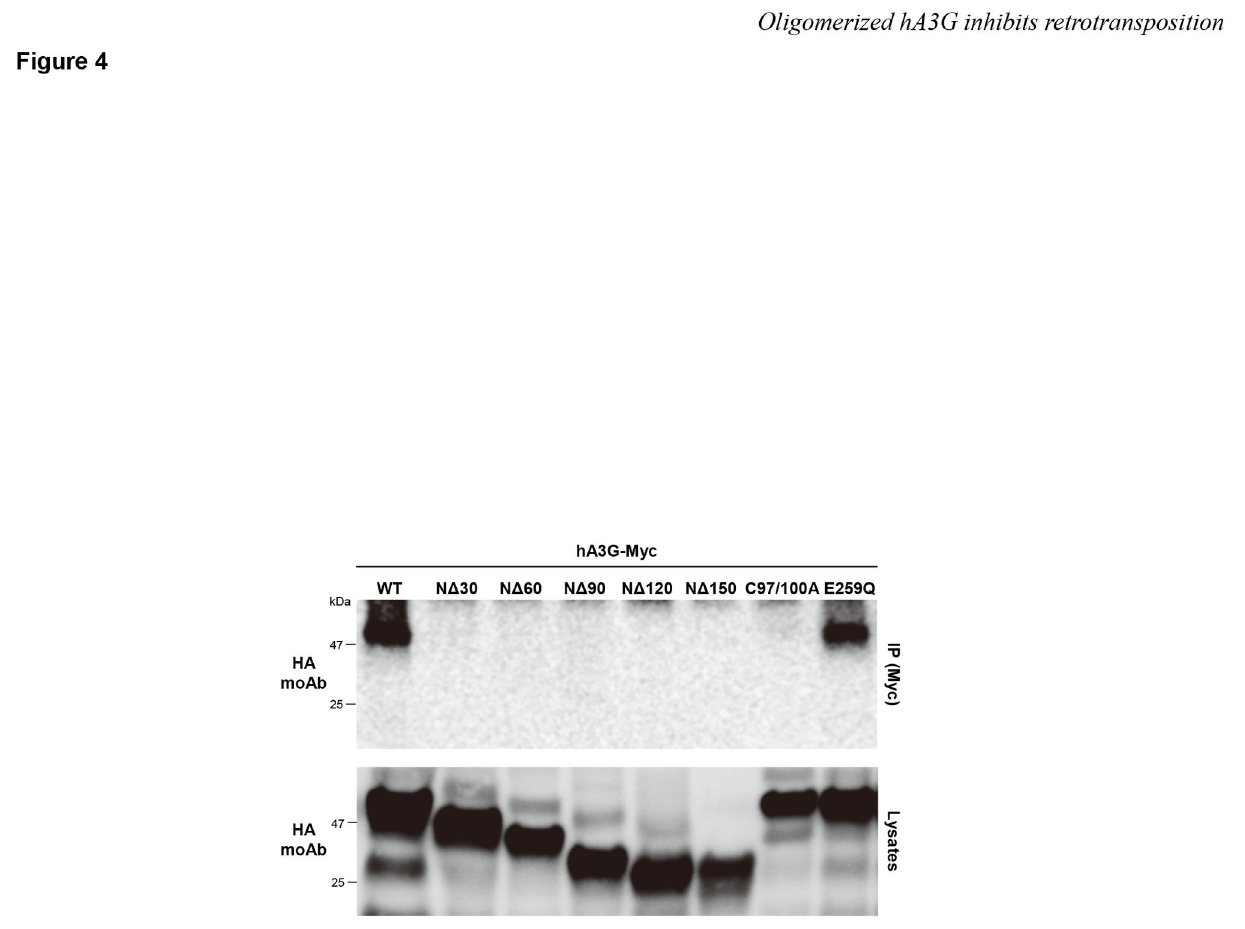
Figure 4. The homooligomerization of hA3G is dependent on the N-terminal 30 amino acid residues of this protein. 293T cells cotransfected with the Myc-tagged and HA-tagged hA3G expression plasmids were immunoprecipitated (IP) with an anti-Myc polyclonal antibody. The resulting complexes were analyzed by immunoblotting with a monoclonal antibody against the HA tag to detect oligomerized hA3G (upper). Cell lysate aliquots were also analyzed in parallel by immunoblotting for the HA tag (lower). WT, wild-type